Question: Summarize what this figure shows in one sentence.
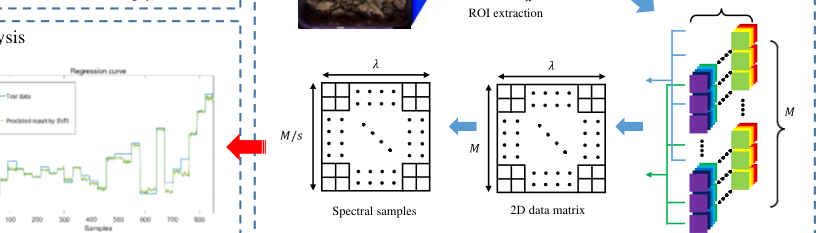
Answer: illustrates the proposed workflow of data processing.  Following data acquisition, the region of interest (ROI) in the  central area is extracted to eliminate regions near the boundaries  that contain shadows. Subsequently, an adaptive thresholding  technique [7] is applied to the ROI to further remove shadow  regions caused by an uneven surface that may obstruct the light  from being evenly distributed on the peat. Let M denote the  number of pixels in masked region of interest, and we randomly  selected s pixels and calculate their average value as a  representative spectral sample to compensate for the fact that the  distribution of phenols on the surface is very uneven. To this end,  we would have M/s spectral samples extracted from the  hypercube. For SWIR data, the average number of pixels for  each class of peat and condensate is 1.04*105 and 1.44*104  respectively. For VNIR data, the average number of pixels for  each class of peat and condensate is 4*105 and 9*104  resp